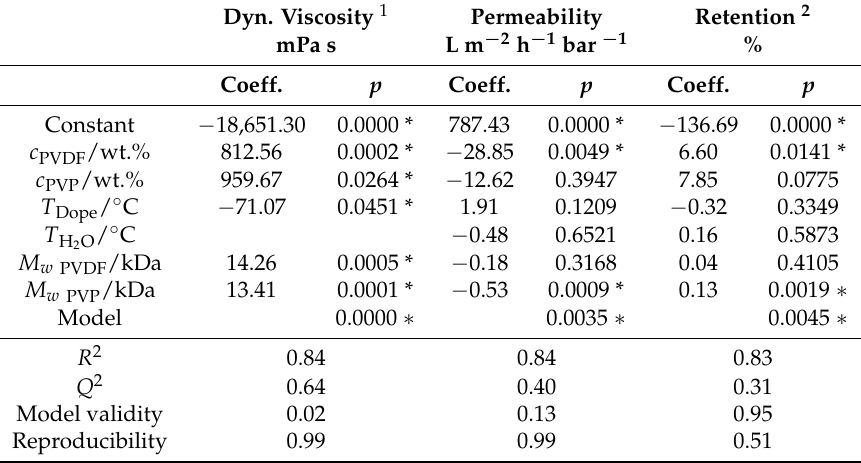
Table 3. Multiple linear regression